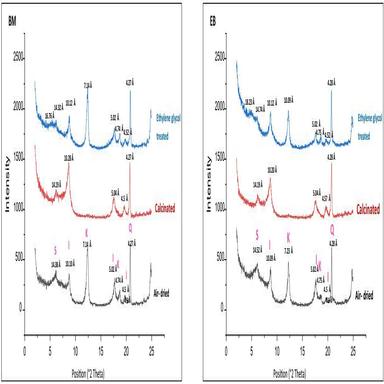
X-Rays diffraction of the two clay samples from Meknes: BM and EB.